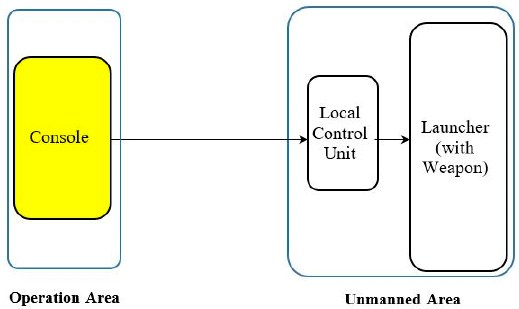
Figure 12. Configuration of the army missile defense system.